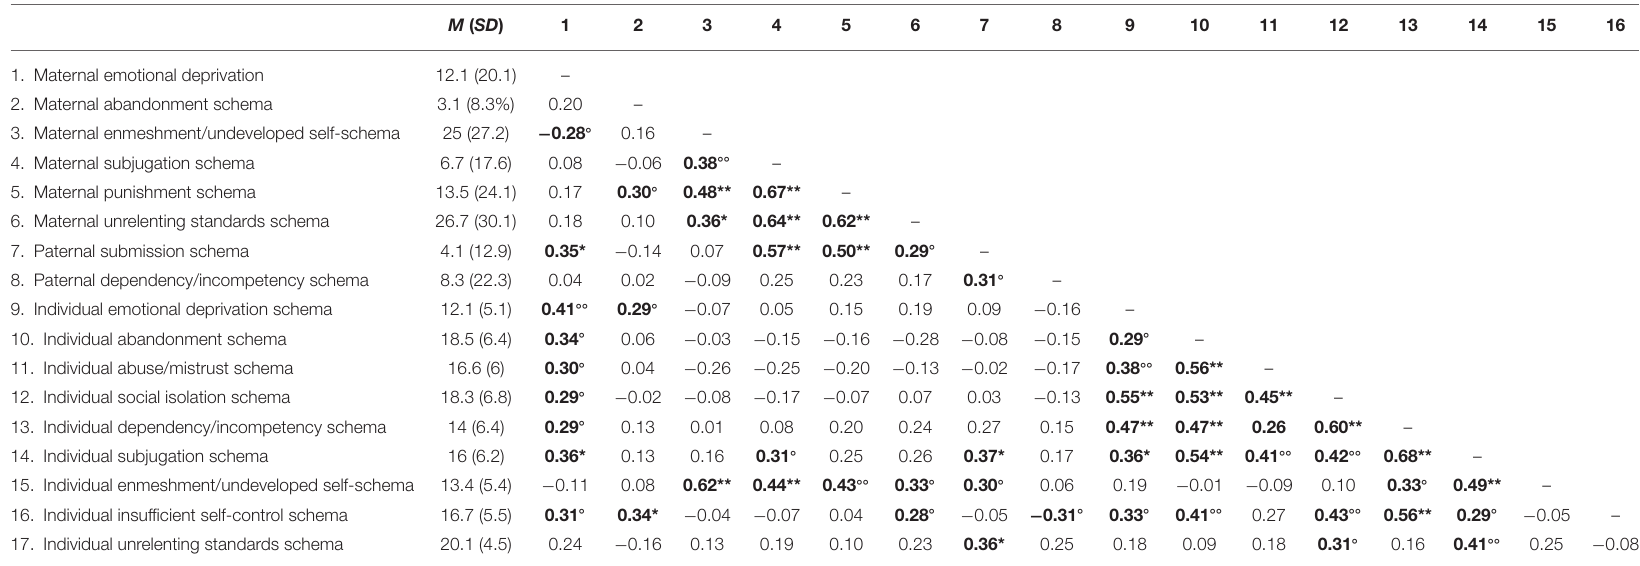
TABLE 3 | Partial correlations measuring the association between parental and individuals schemas, controlling for BMI and depression, are